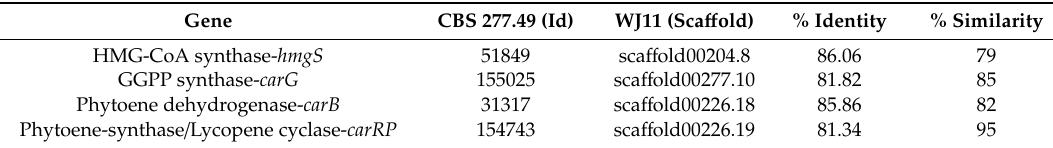
Table 2. Identification of key genes analyzed in this study by